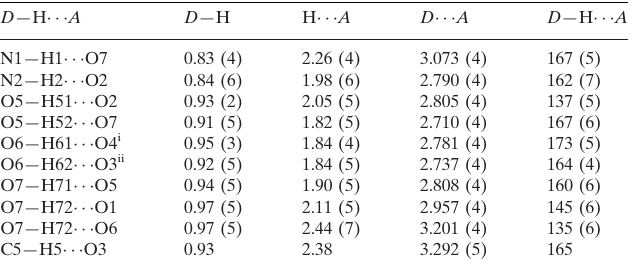
Hydrogen-bond geometry (A˚ , (cid:3)